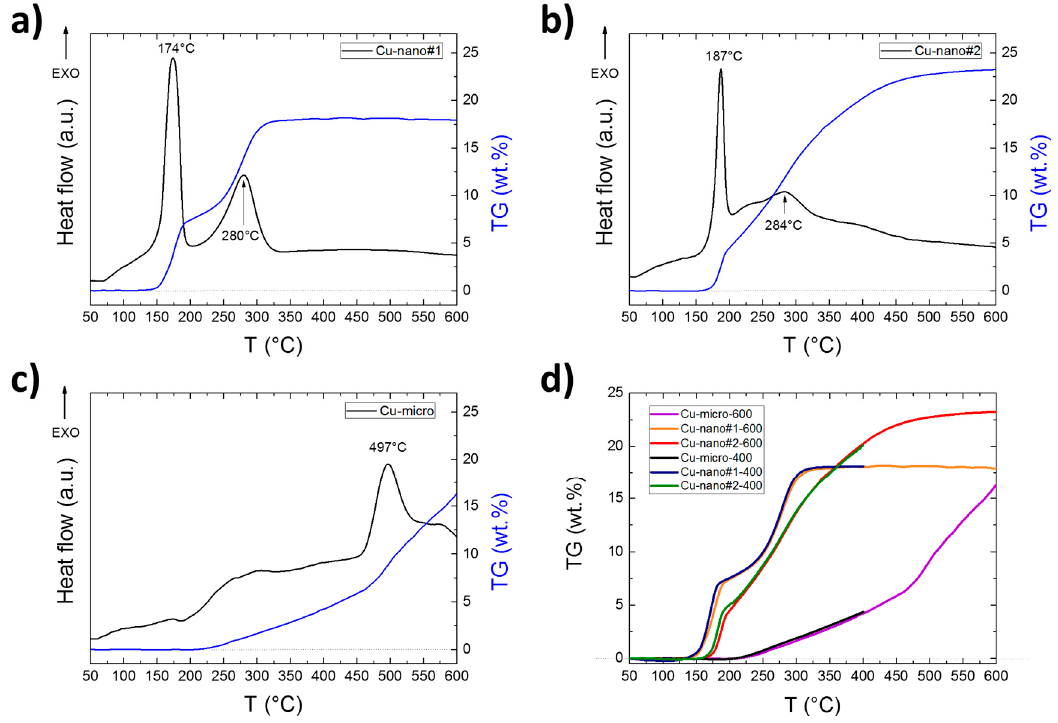
Figure 3. DTA and TG curves obtained by simultaneous thermal analysis (STA) for ( a ) Cu-nano#1, ( b ) Cu-nano#2, ( c ) Cu-micro and ( d ) comparison of TG curves measured to 400 and 600 °C. Table 2. Results of STA (final temperature 400 or 600 °C), phase composition was obtained by Rietveld analysis.